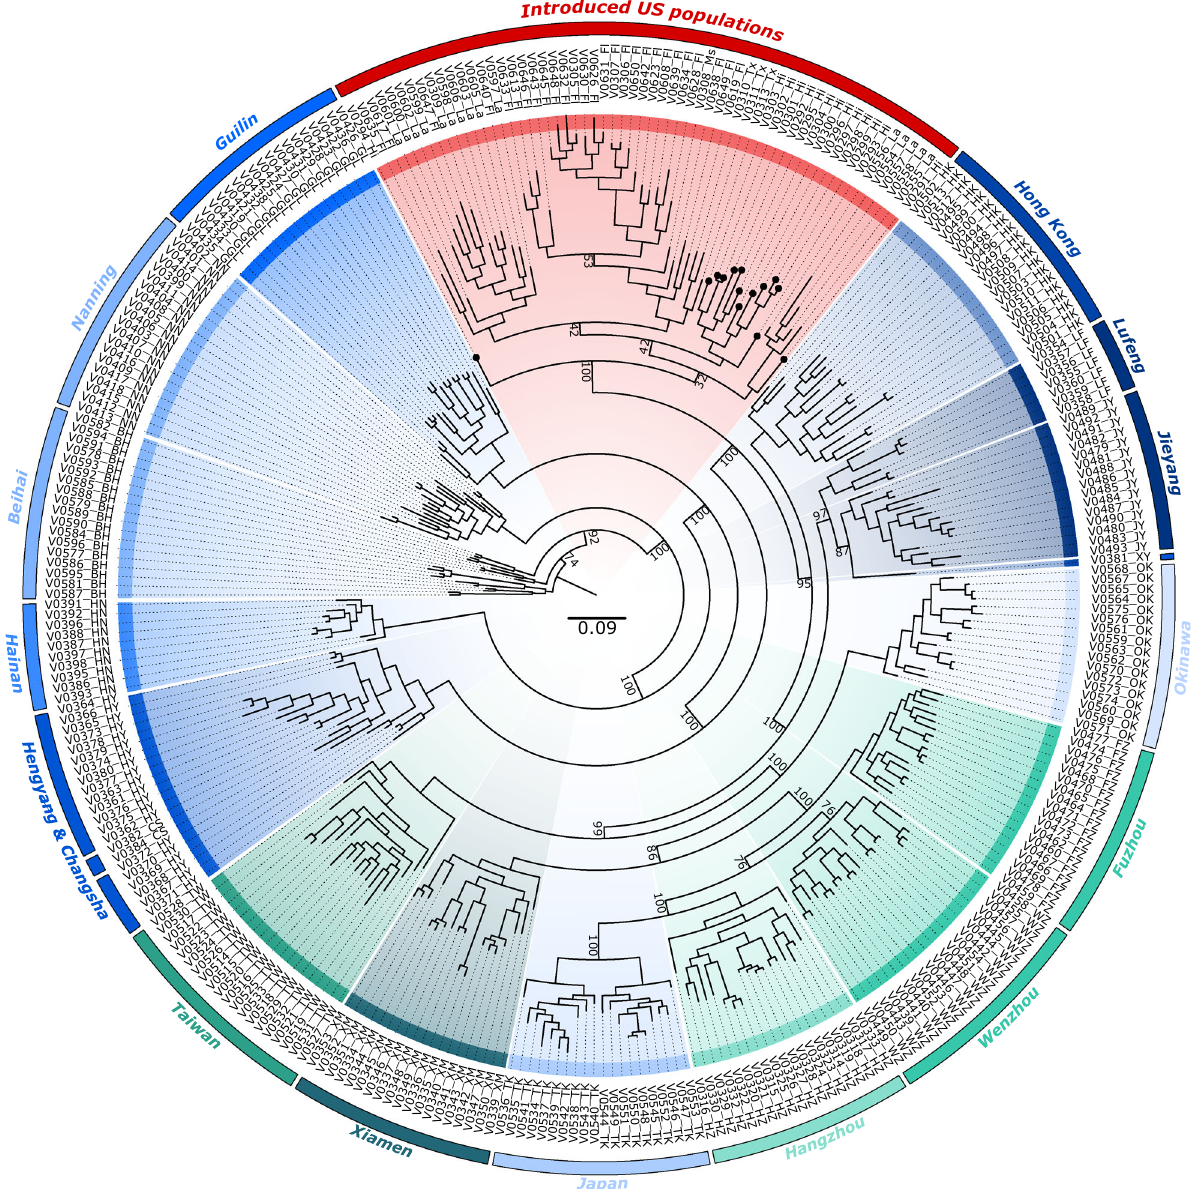
Fig. 4 Maximum likelihood phylogenetic tree of C. formosanus . The sampling locations are colored according to their fastSTRUCTURE assignments ( K = 15). For clarity, bootstrap values are only indicated for major branching events. Samples from Hawaii are highlighted with a round